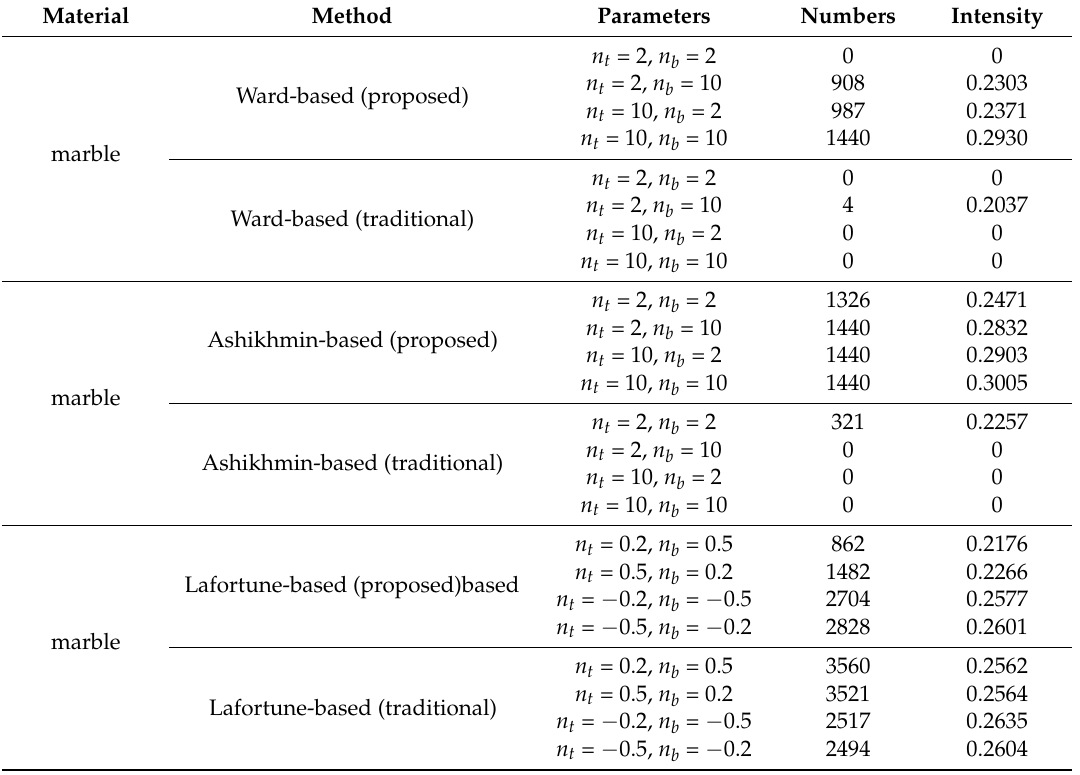
Table 1. Number and Intensity of generated highlight for marble material.